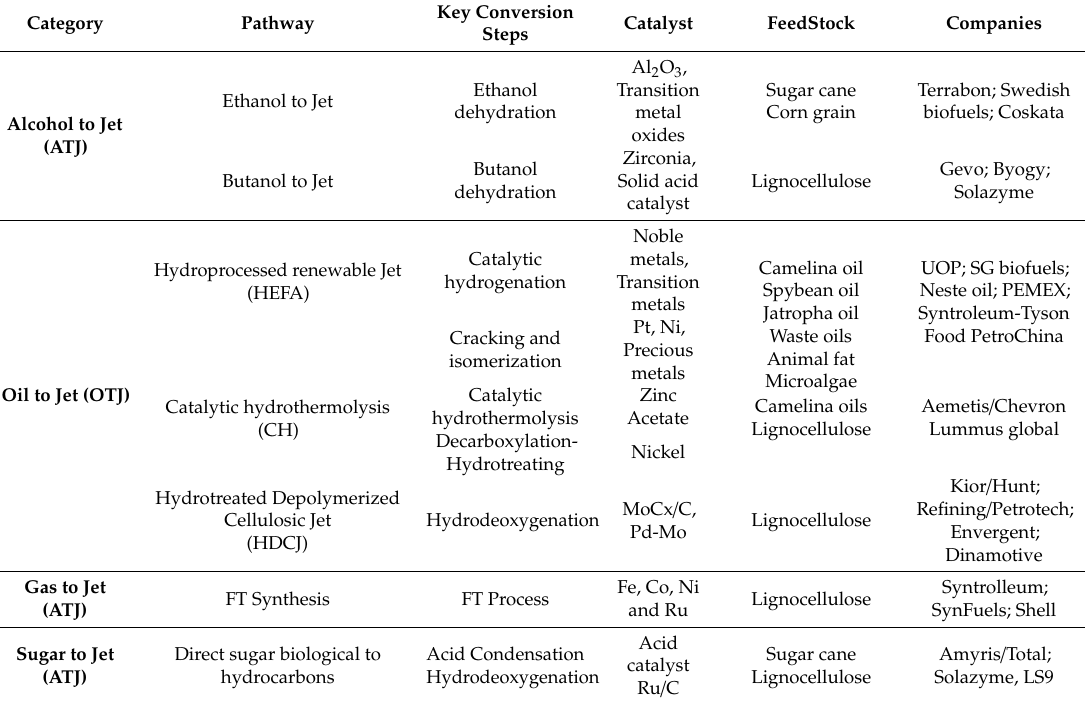
Table 1. Summary of bio-jet fuel production pathways. Data obtained from